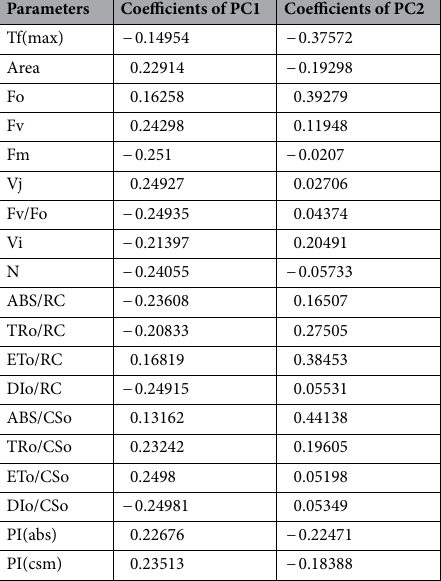
Table 1. Principal component analysis of chlorophyll a flourescence parameters of L. minor under various concentration of